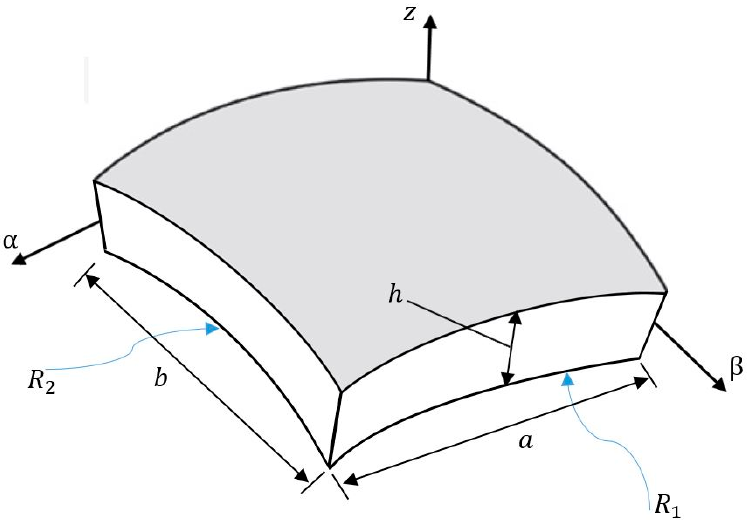
Figure 1. Geometry of a P-FGM doubly-curved nanoshell.